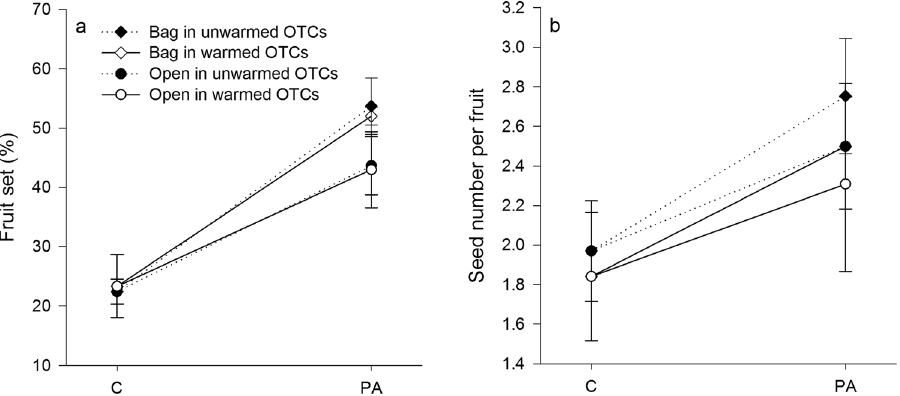
Figure 1. The effects of pollination treatments (control [C] vs. supplemental hand pollination [PA]) and warming (unwarmed vs. warmed) on ( a ) fruit set, and ( b ) seed number per fruit in Caragana microphylla